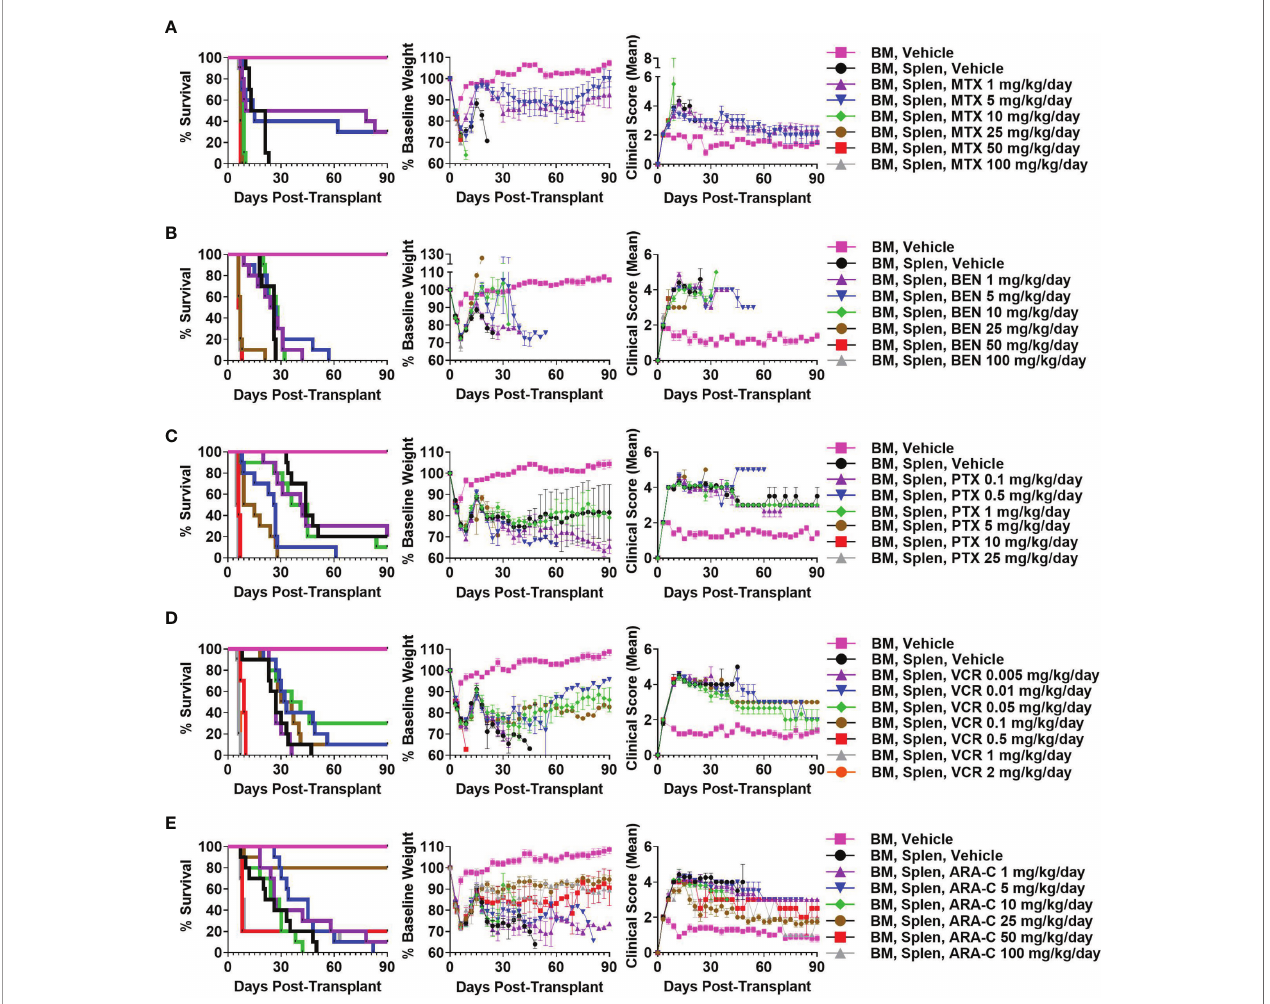
FIGURE 1 | Methotrexate (MTX) 5 mg/kg/day, bendamustine (BEN) 10 mg/kg/day, paclitaxel (PTX) 1 mg/kg/day, vincristine (VCR) 0.05 mg/kg/day, and cytarabine (ARA-C) 25 mg/kg/day are optimal doses of each drug when given on days +3/+4 in the B6C3F1 ! B6D2F1 MHC-haploidentical hematopoietic cell transplantation (HCT) model. On day 0, recipient 10-12-week-old female B6D2F1 mice were irradiated to 10.5 Gy in a single fraction and transplanted 6-8 hours later via intravenous injection with 10 x 10 6 T-cell-depleted bone marrow (BM) cells +/- 40 x 10 6 red-blood-cell-depleted splenocytes (Splen) from 10-12-week-old female B6C3F1 donors. Phosphate buffered saline (PBS) vehicle or the chemotherapeutic of interest was administered intraperitoneally on days +3 and +4. Although different chemotherapeutics had varying ef fi cacy in mitigating fatal or severe graft-versus-host disease (GVHD), (A) MTX 5 mg/kg/day, (B) BEN 10 mg/kg/day, (C) PTX 1 mg/kg/day, (D) VCR 0.05 mg/kg/day, and (E) ARA-C 25 mg/kg/day were determined as optimal doses for each drug due to superior survival, weights, and/or clinical scores. Combined results from two independent experiments of n = 5 mice/group/experiment are